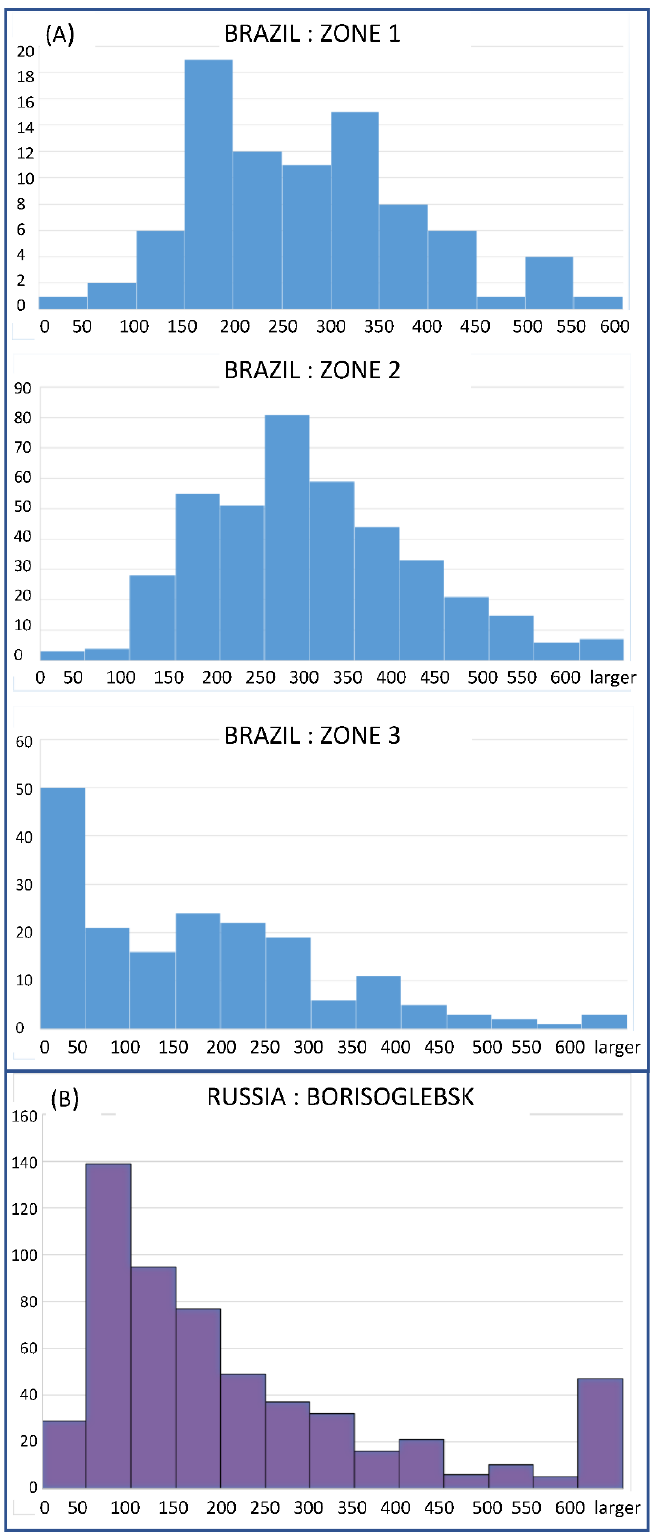
Figure 4. Diameter equivalent statistic on the three zones in Brazil ( A ) and Russia ( B ). Horizontal axis represents the equivalent diameters, values in meters, the vertical axis is the number of structures per interval of 50 m. The total number that is variable depending of the area, see Table 1. The Russian data are from) [8] but shown using the same scale as for Brazil. All the large depressions, with a diameter larger than 600 m, are grouped within the last column.